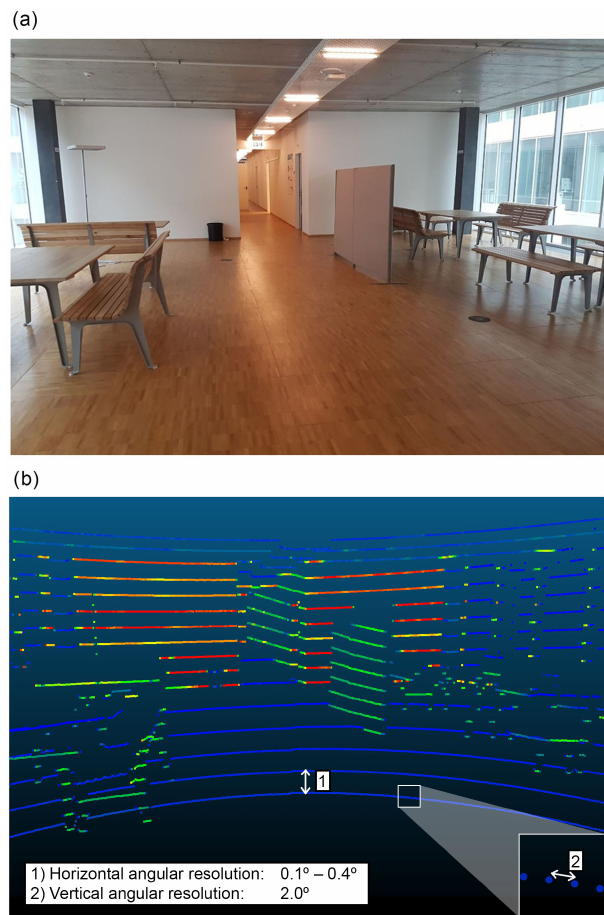
Figure 1. (a) Picture of the scanned scene; (b) a typical scan created with the VLP-16, the colour represents the intensity of the returned